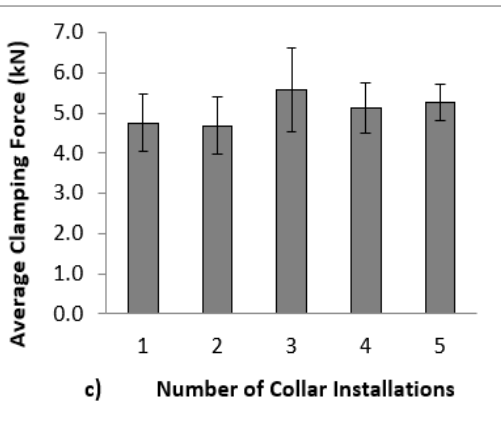
Figure 8. Average clamping force vs. number of collar installations for ( a ) static shear tests; ( b ) static tension tests and ( c ) shear fatigue tests (error bars represent ±1 standard deviation).